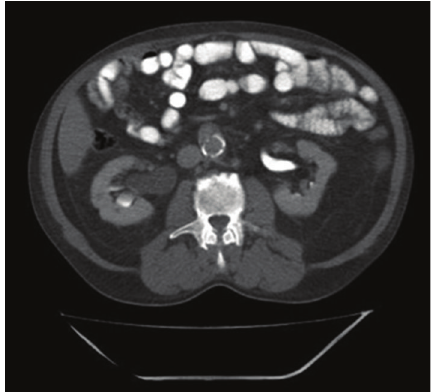
Figure 2: Computer tomography with hydronephrosis of the right kidney.